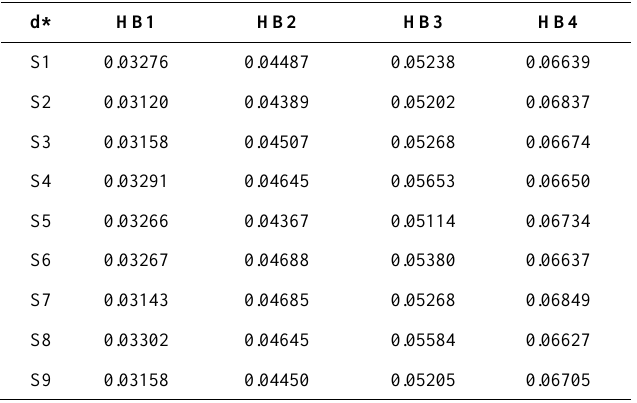
Table 12. Value Matrix 𝒅 𝒊+ Strategy for Process/Business